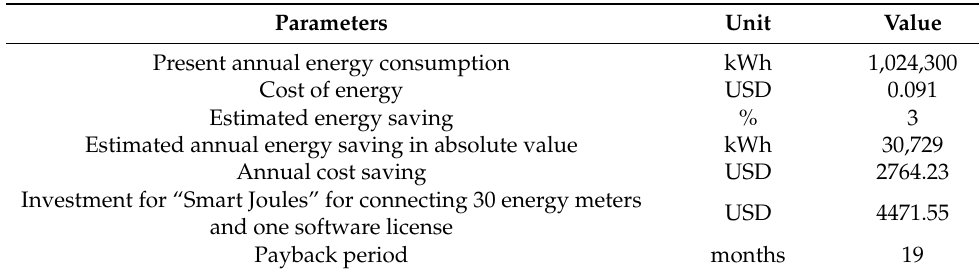
Table 15. Energy saving estimation by installing “Smart